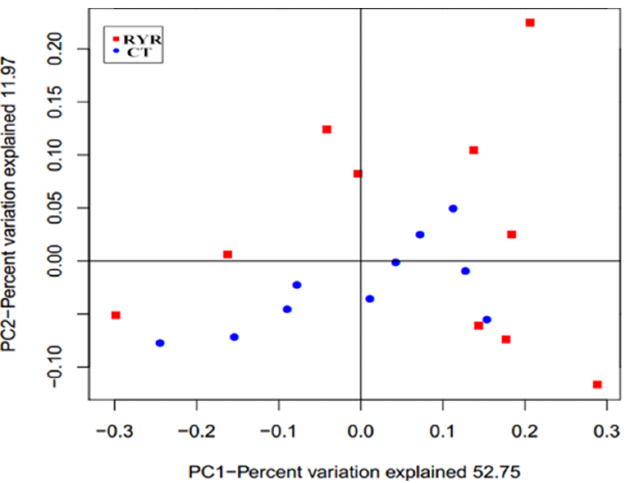
Fig 2. Principal Co-ordinate Analysis (PCoA) of archaeal Operational Taxonomic Units from goat rumen